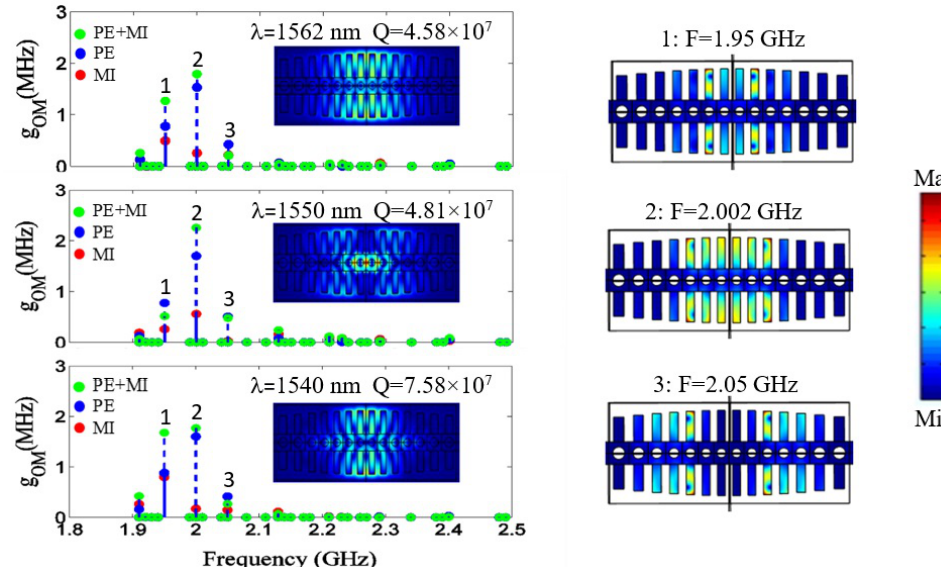
Figure 7. Tapered cavity: optomechanical coupling with phonons around 2 GHz and maps of the phonon cavity modes. Both photoelastic (PE) and moving interface (MI) effects are